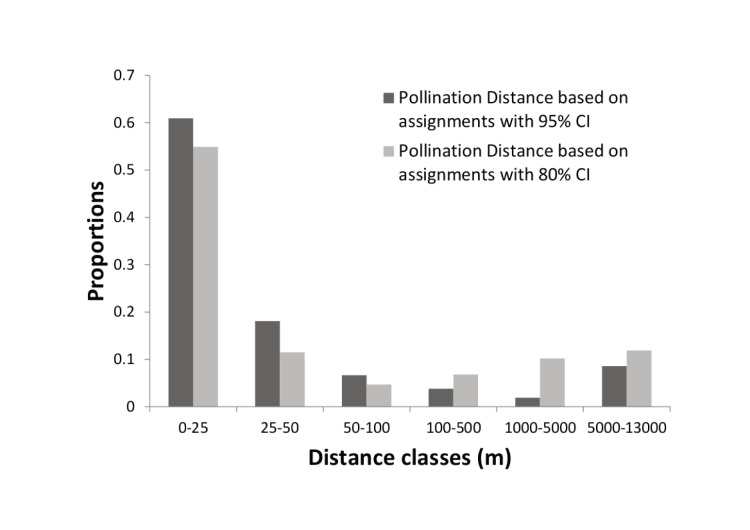
Frequency distributions of realised pollen flow distances in Glionnetia sericea populations, calculated from n = 105 juveniles and parent pairs for the 95% CI (dark grey) and n = 235 for the 80% CI (light grey).